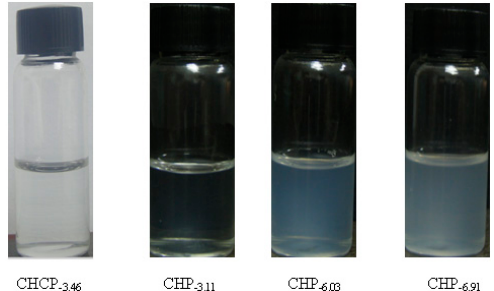
Figure 4. The optical appearance of pullulan nanoparticles with different hydrophobicity and surface charge.